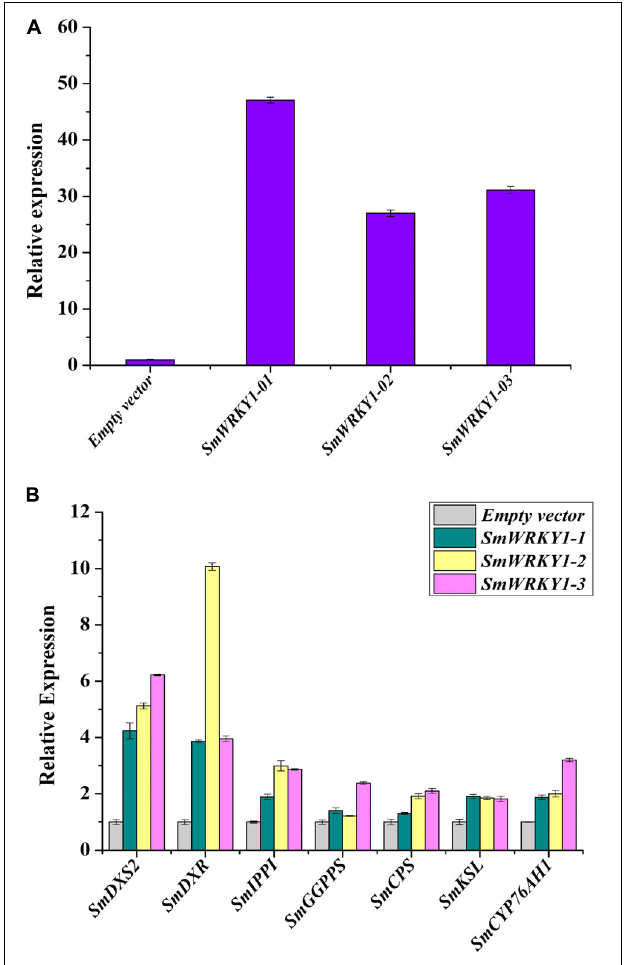
FIGURE 6 | Transcript levels of SmWRKY1 and genes related to tanshinones biosynthesis in SmWRKY1 transgenic hairy roots. Expression of SmWRKY1 was analyzed by qRT-PCR. All data are means of three replicates, with error bars indicating Standard Deviation. (A) The transcript level of SmWRKY1 in SmWRKY1 transgenic hairy roots. (B) The transcript level of the key tanshinones biosynthesis genes in SmWRKY1 transgenic hairy roots.